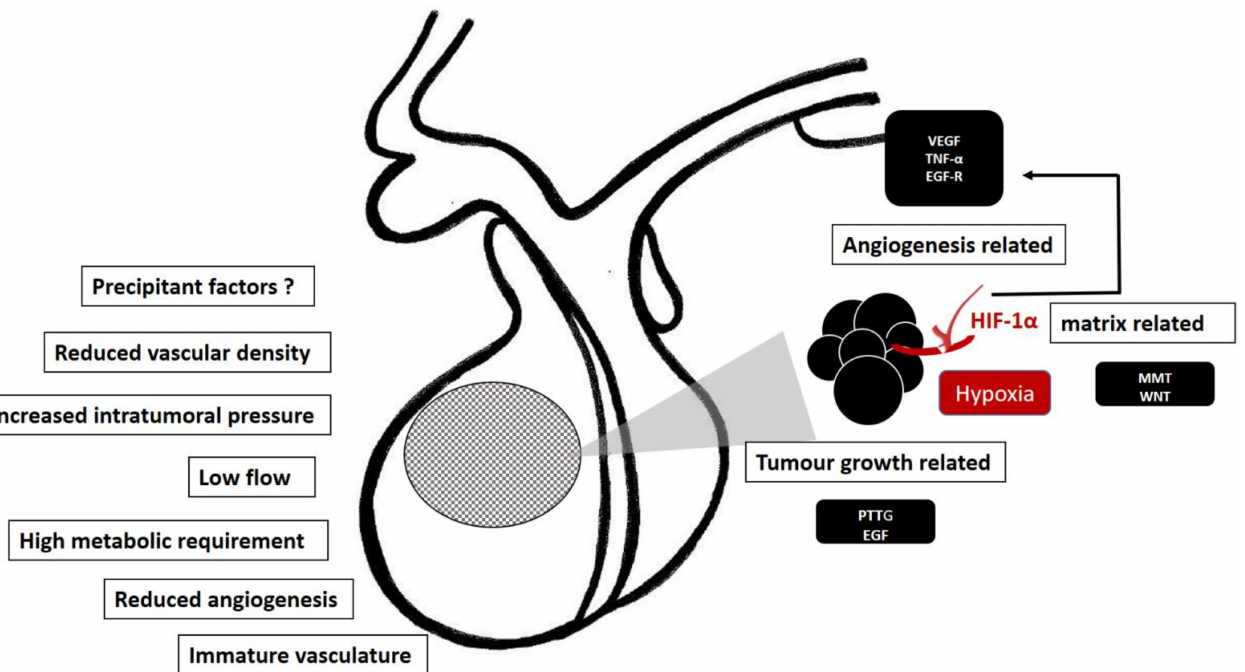
Figure 3. Predisposing factors and molecular mechanism involved in the pathogenesis of pituitary apoplexy. Some intrinsic characteristics facilitating the apoplectic event (left side). Hypoxia is a plausible molecular trigger of hypoxia-mediated factors, HIF-1 α /VEGF and MMP pathways, promoting the tumor growth and angiogenesis, thus making the pituitary tumor prone to apoplectic events (right